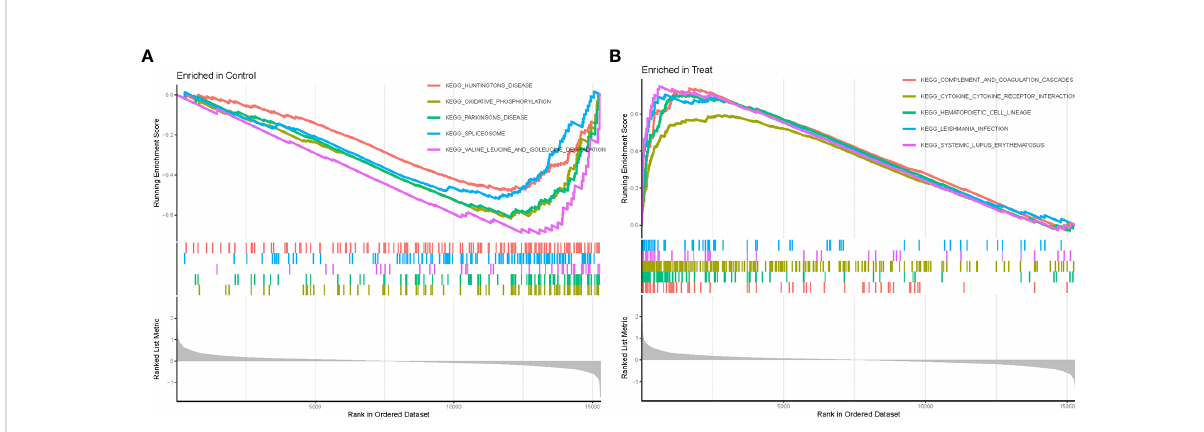
FIGURE 3 GSEA enrichment analysis. (A) KEGG pathway set scores enriched in the control group. (B) KEGG pathway set scores enriched in the Treat